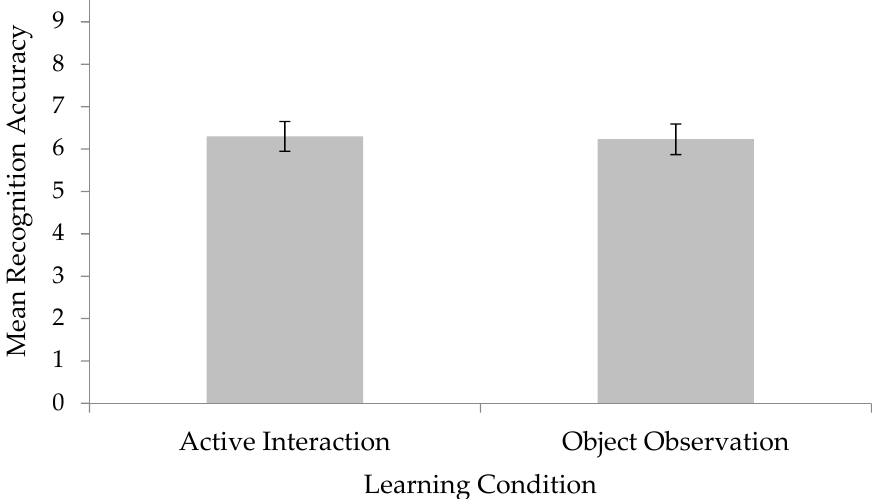
Figure 2. Mean recognition accuracy for children in each of the two learning conditions in Experiment 2. Error bars represent standard errors.